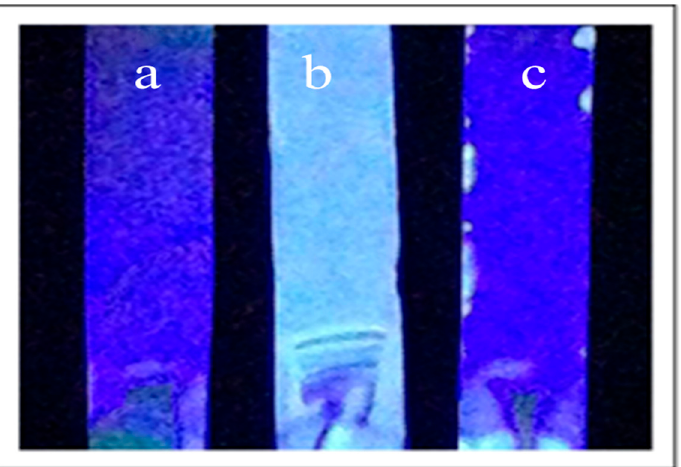
Figure 10. Fluorescence photographs of the same test strip under following conditions: ( a ) before immersion, ( b ) shortly after immersion in an aqueous solution containing CuCl 2, ( c ) test strip in ( b ) is treated in a KCN containing aqueous solution.